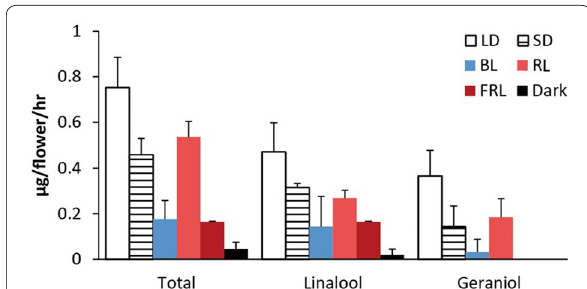
Fig. 2 Emission of monoterpenes from P. violacea flowers in different light condition. The plants were treated with 100 μmol m − 2 s − 1 white light in long day (18 h/6 h L/D, LD) and short day (6 h/18 h L/D, SD) conditions, 270 μmol m − 2 s − 1 blue light (BL), 30 μmol m − 2 s − 1 red light (RL), 5 μmol m − 2 s − 1 far‑red light (FRL), and darkness (dark). Scent was collected on D 5 of an individual P. violacea flower. + Experiments were based on triplicate biological replicates